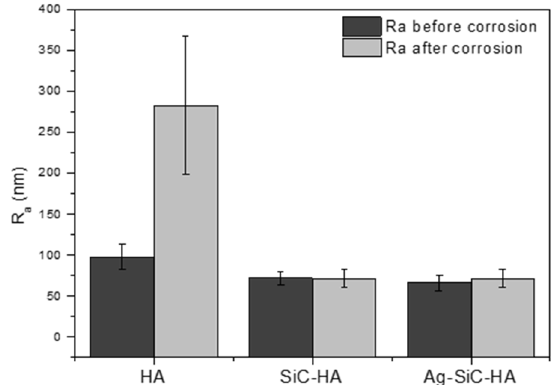
Figure 10. The modification of the Ra roughness parameter of the coatings due to the corrosion attack in SBF solution.